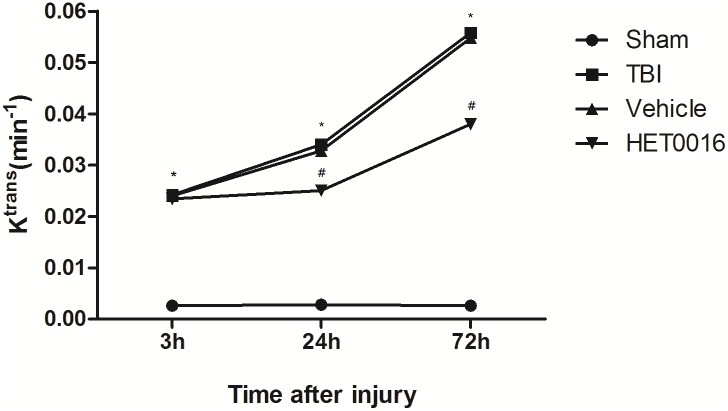
The effect of HET0016 on the blood–brain barrier permeability. In the focal area, Ktrans in the sham, TBI, vehicle and HET0016-treated groups at 3, 24, and 72 h after injury. Data are represented as the mean ± SD. ∗P < 0.05 compared with the corresponding sham group at the same time point; #P < 0.05 compared with the vehicle-treated group.